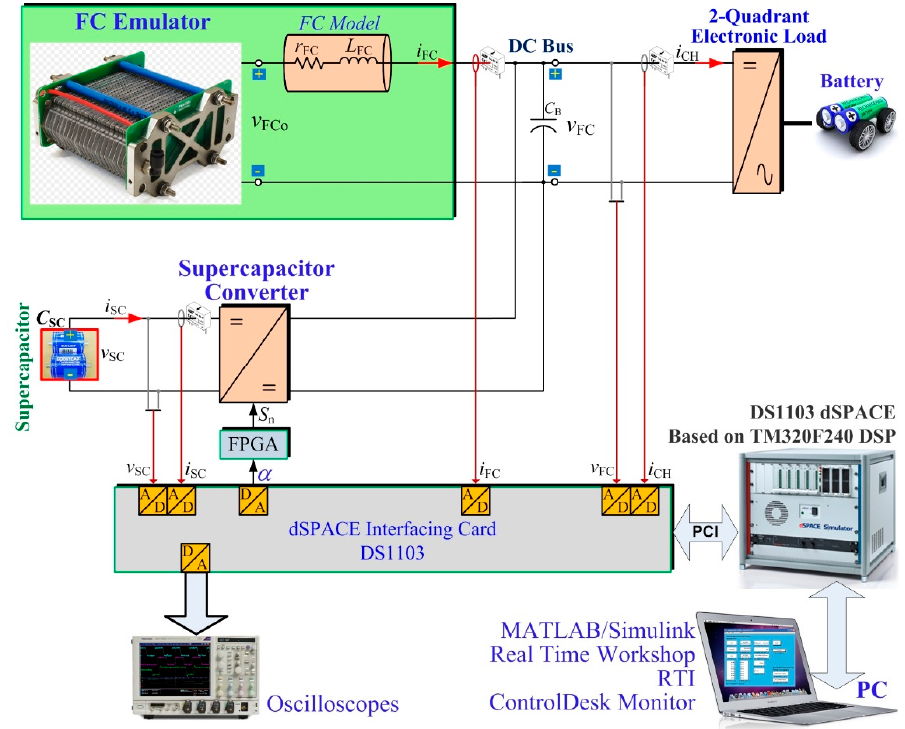
Figure 14. Real-time laboratory test bench.